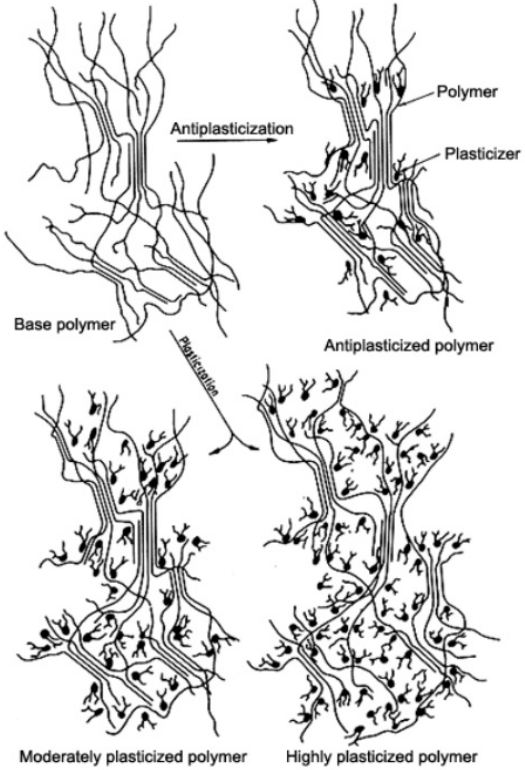
Figure 4. Illustration of antiplasticization and plasticization of a resin [59].